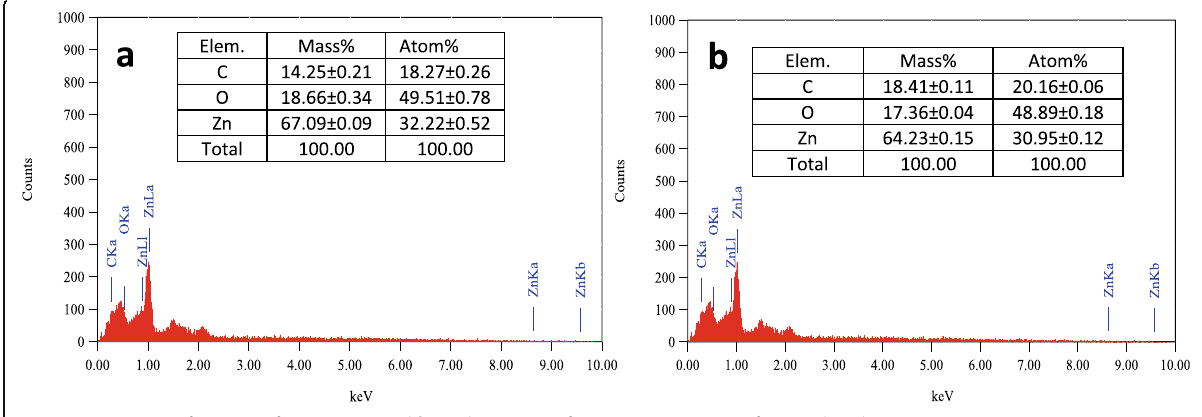
Fig. 3 EDX spectra of ZnO NPs from a ZnAc and b ZnCl 2 precursor from aqueous extract of A. occidentale